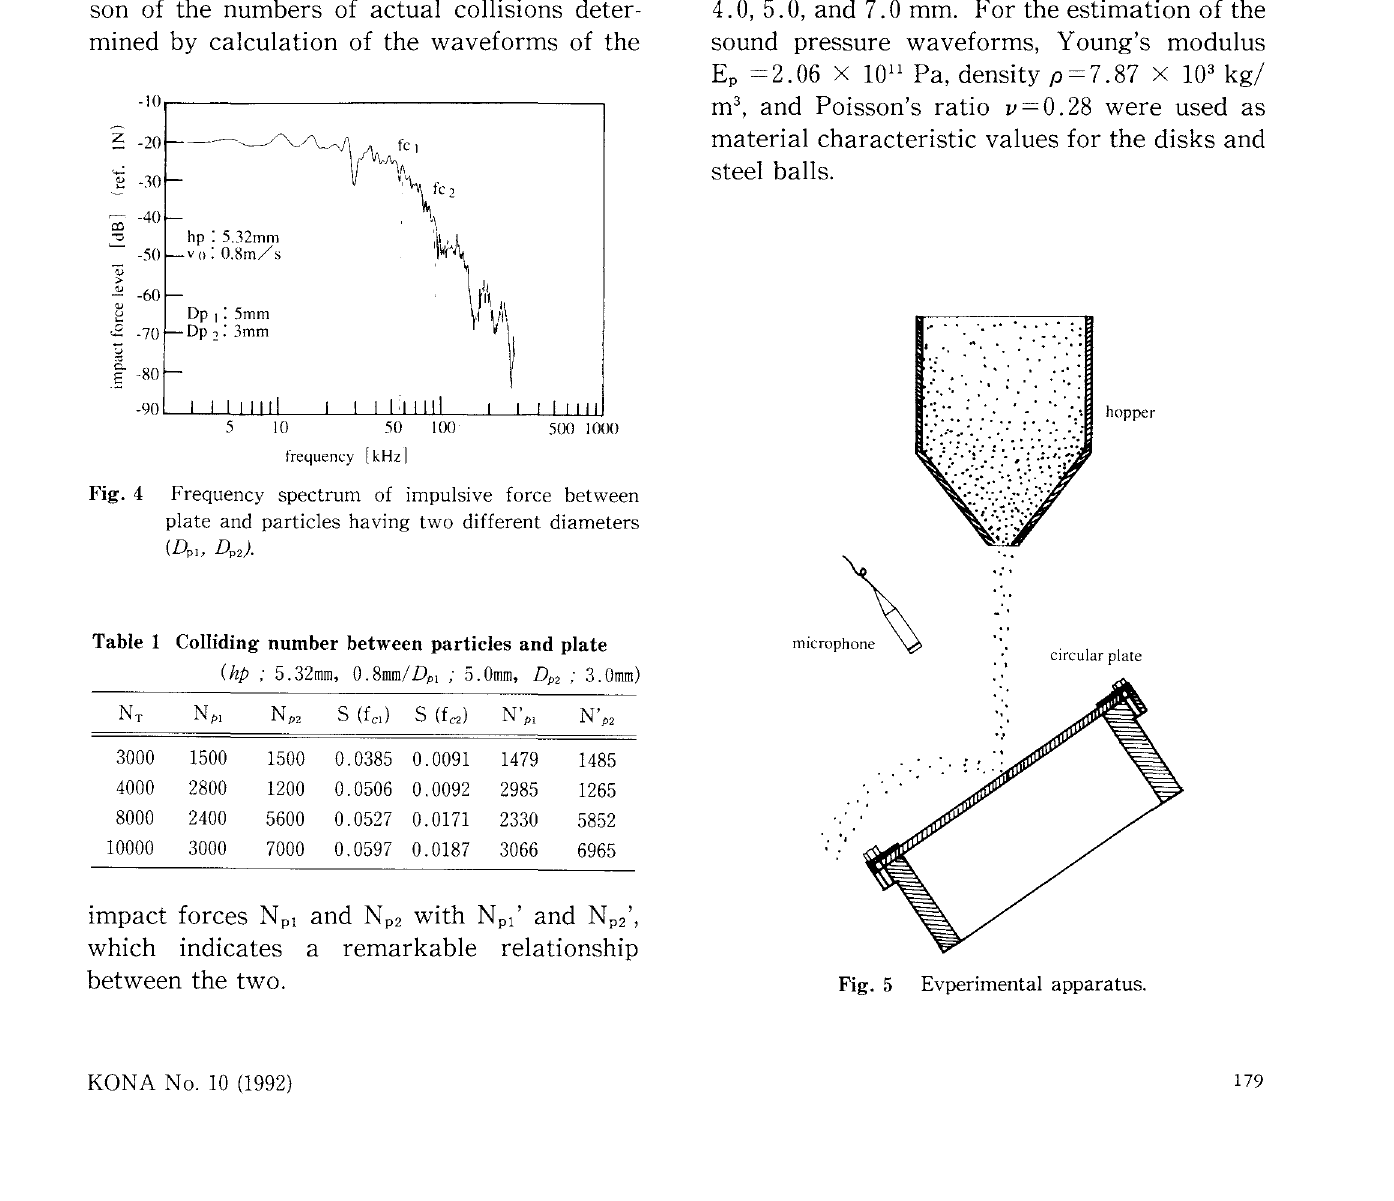
Fig. 4 Frequency spectrum of impulsive force between plate and particles having two different diameters (Dpr, Dp,).